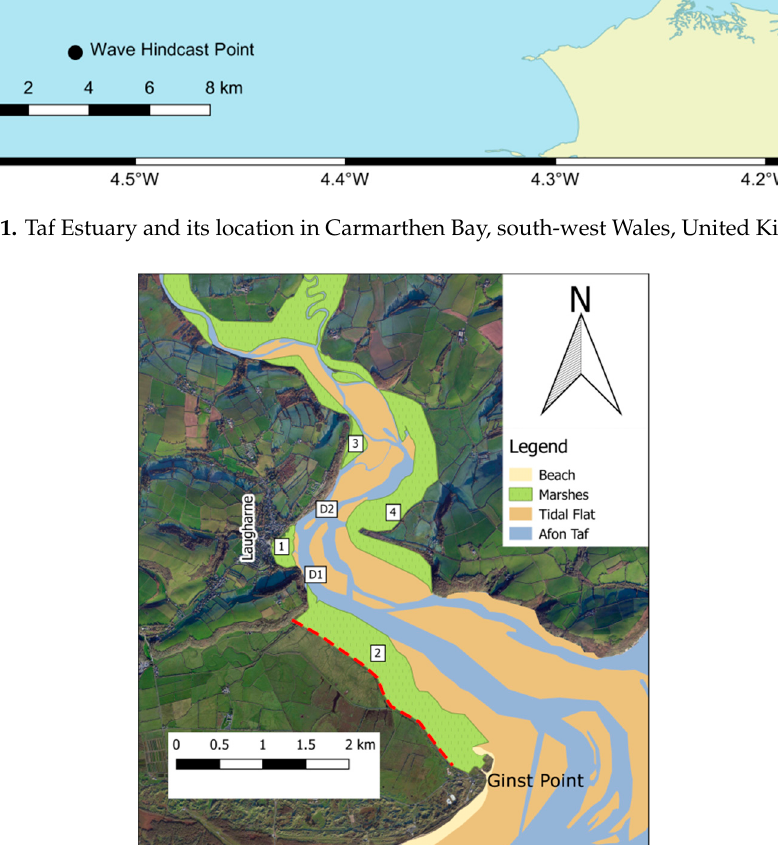
Figure 1. Taf Estuary and its location in Carmarthen Bay, south ‐ west Wales, United Kingdom.